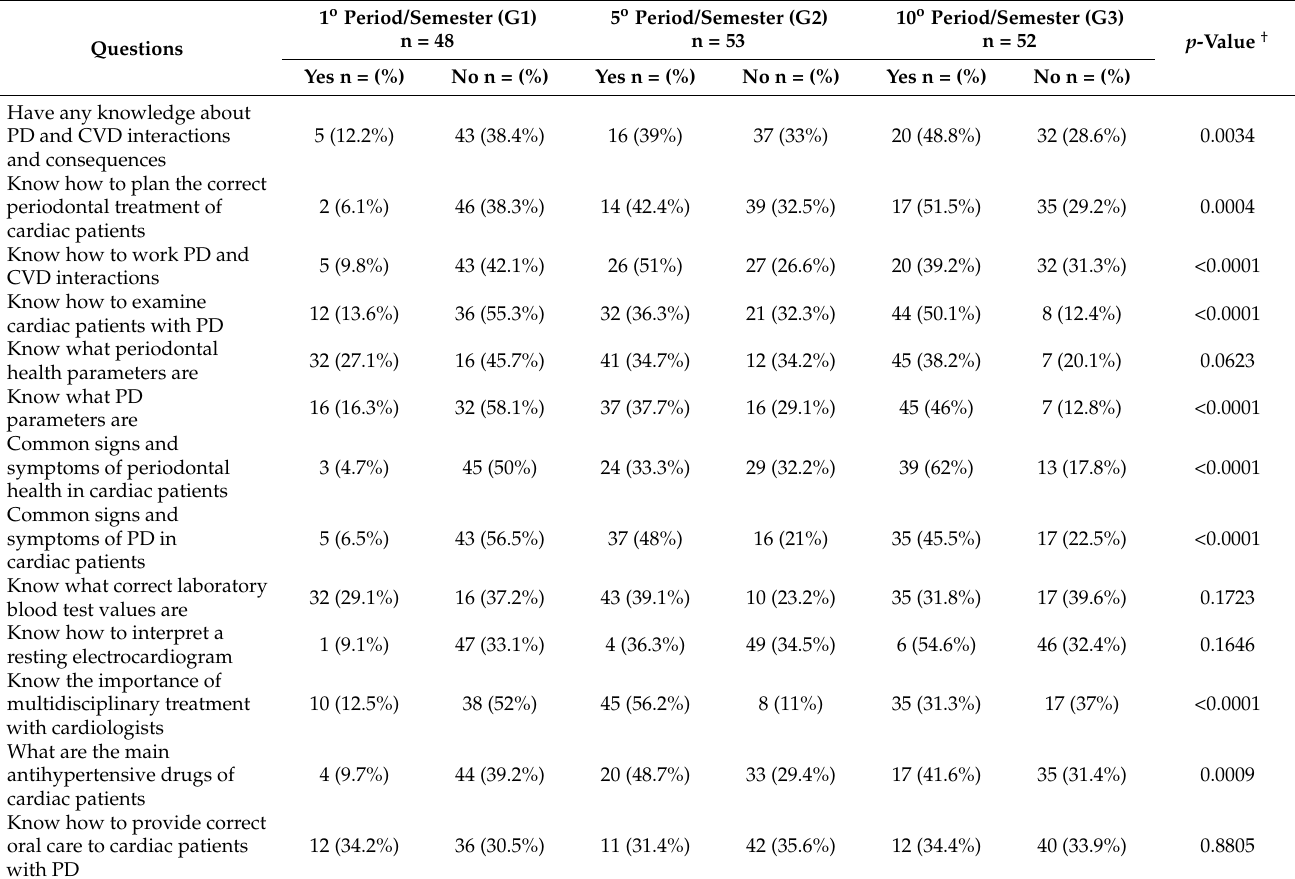
Table 3. Technical knowledge of DUS about cardiac patient management through each